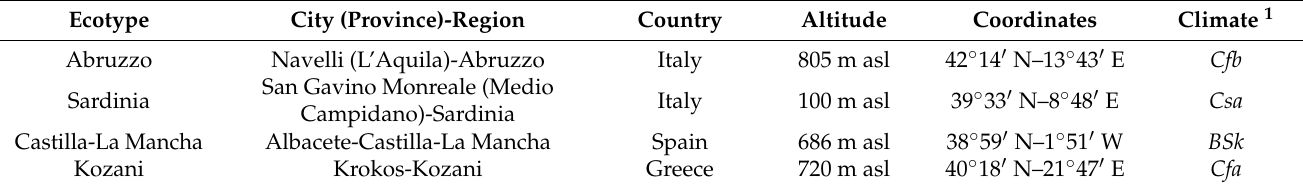
Table 1. Origin of the selected saffron